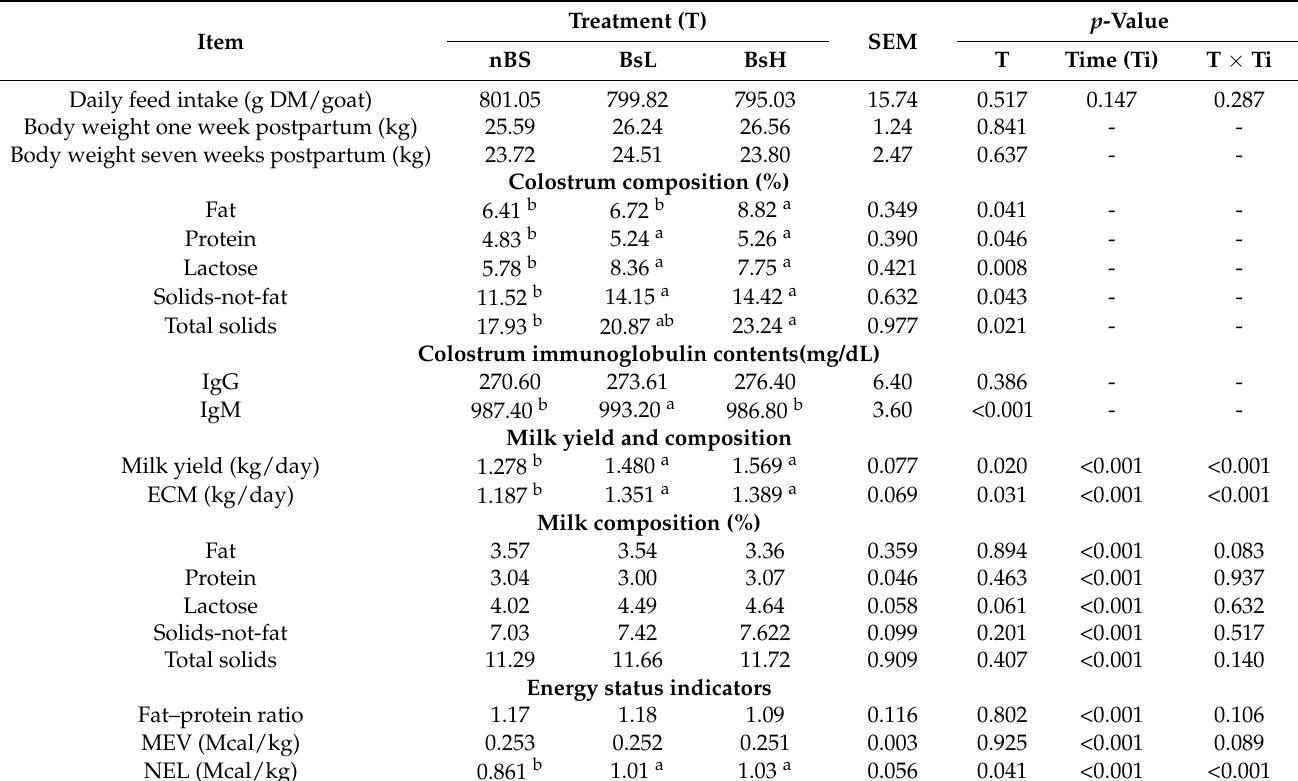
Table 5. Feed intake, body weights, colostrum composition and immunoglobulin contents, milk yield and composition, and energy indicators for transitioning goats that received 0 (nBS), 2 (BsL), and 4 (BsH) g of Boswellia sacra resin daily from